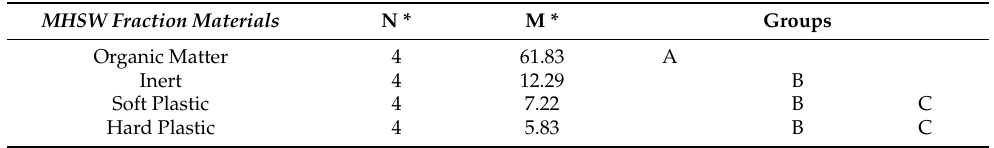
Table 8. TURKEY test applied to the percentages of each MHSW fraction material in relation to the total mass of the sample for the gravimetric analysis of